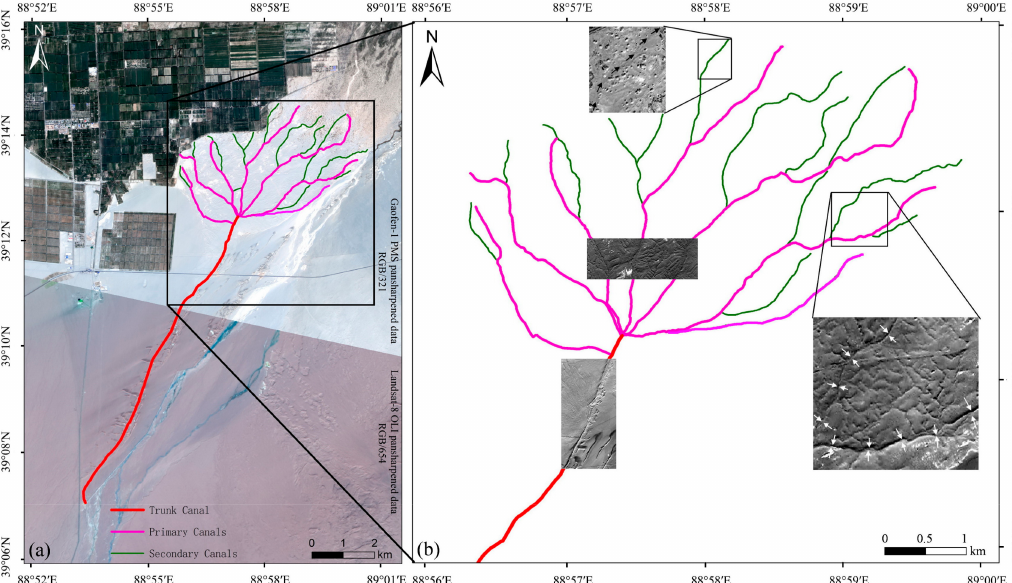
Figure 3. General schematic of the Miran TICs system ( a ) without tertiary TICs from 2 m GF-1 PMS pansharpened data (RGB321) and Landsat-8 OLI pansharpened data (RGB654). The inset images in ( b ) are the GF-1 sub-PAN imagery; the white arrows indicate the tuntian irrigation